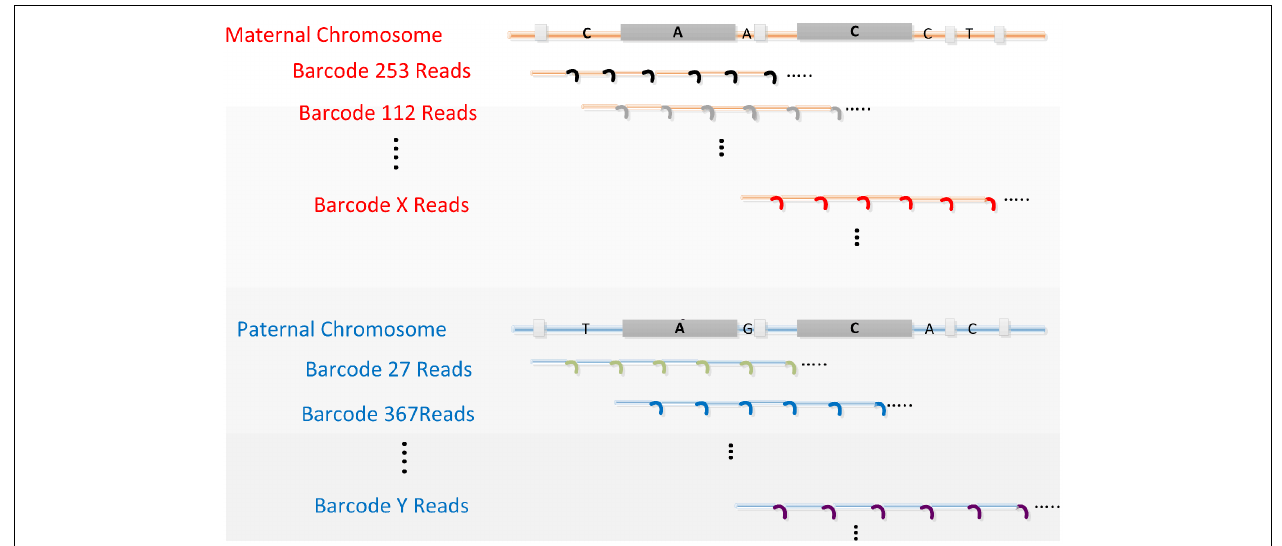
having the same barcode. Reads belonging to related (i.e., overlapped) long fragments mostly have different barcodes. Consequently maternal (red) and paternal (blue) fragments for a genomic region have different barcodes as indicated by the distinct barcode numbers (253, 112, and X for mom, 27, 367, and Y for dad). After MPS, barcodes are used to aggregate reads from the original long fragment. Such read aggregation, even without sequence assembly per long fragment, provides information for variant phasing and repeat resolving when reads from overlapping long fragments, representing the same chromosome, are used together in the assembly process. (3) Sequence reads must cover > 30% and preferably the majority of bases in each long fragment. Consecutive continuous reads (depicted here) or overlapping mate-pair reads (two shorter reads from the ends of the same subfragment) can provide the needed coverage. Sequencing the majority of bases of each fragment with co-barcoded reads links alleles in haplotypes as, on average, 10 or more heterozygous sites occur per long DNA fragment. (4) The read or mate-pair length is longer than the frequent dispersed repeats (e.g., Alu, depicted by the small gray boxes) and are correctly assembled primarily using read level